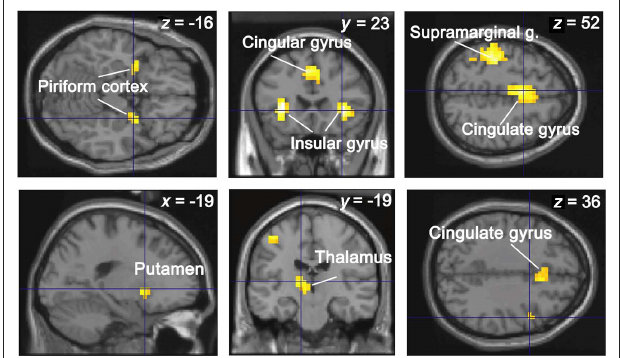
FIguRe 3 | Conjunction analysis between the four response categories and two groups. The activations are superimposed on sections of the normalized Tl-weighted structural scan. The level of significance was set atp < 0.0001 for display, uncorrected at the cluster level for multiple comparisons.